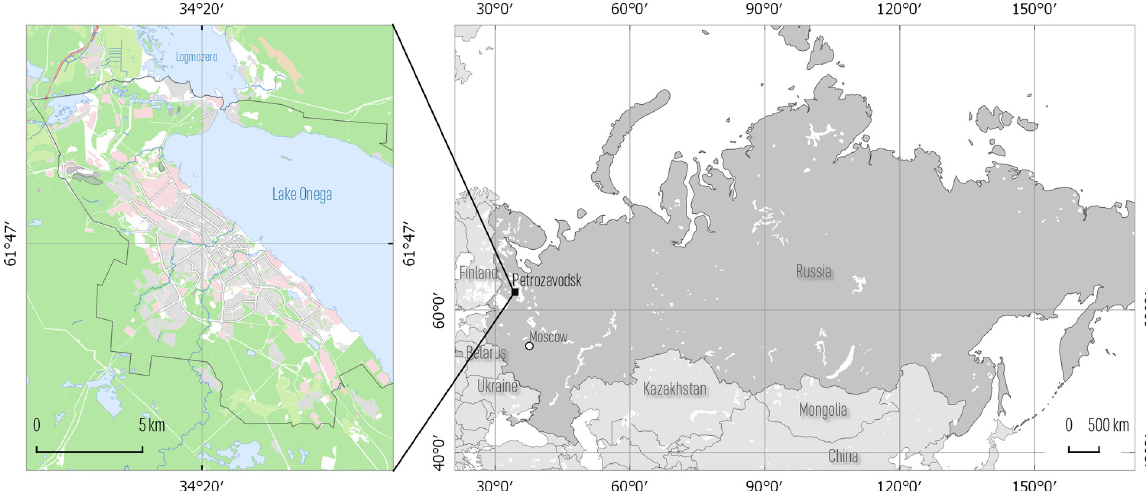
Fig. 1. Location of the research